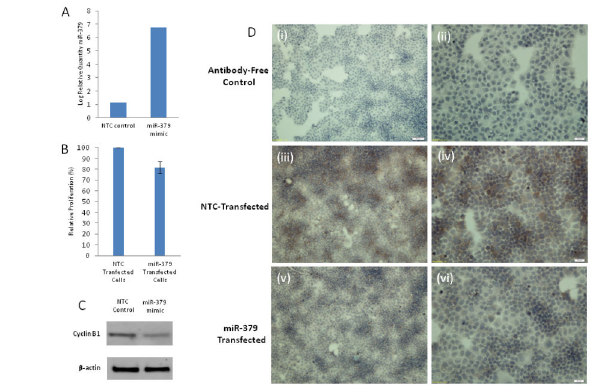
Figure 4. Transfection of T47D cells with miR-379 or a non-targeting control (NTC) mimic. (A) Confirmation of elevated miR-379 expression 48 hours following transfection with miR-379 mimic. (B) Cell proliferation following transfection, resulting in a decrease in proliferation (range 7-24%) in the presence of a miR-379 mimic (p<0.05). (C) The effect of miR-379 transfection on Cyclin B1 protein expression was also determined at 48 hours through western blot (C) and immunohistochemistry (D) (i, ii) antibody-free, (iii, iv) Cells transfected with NTC mimic, (v, vi) Cells transfected with miR-379 mimic for 48h, observed significantly reduced Cyclin B1 expression. Magnification (i, iii, v) 10X (50µm scale bar) and (ii, iv, vi) 20X (20µm scale bar).